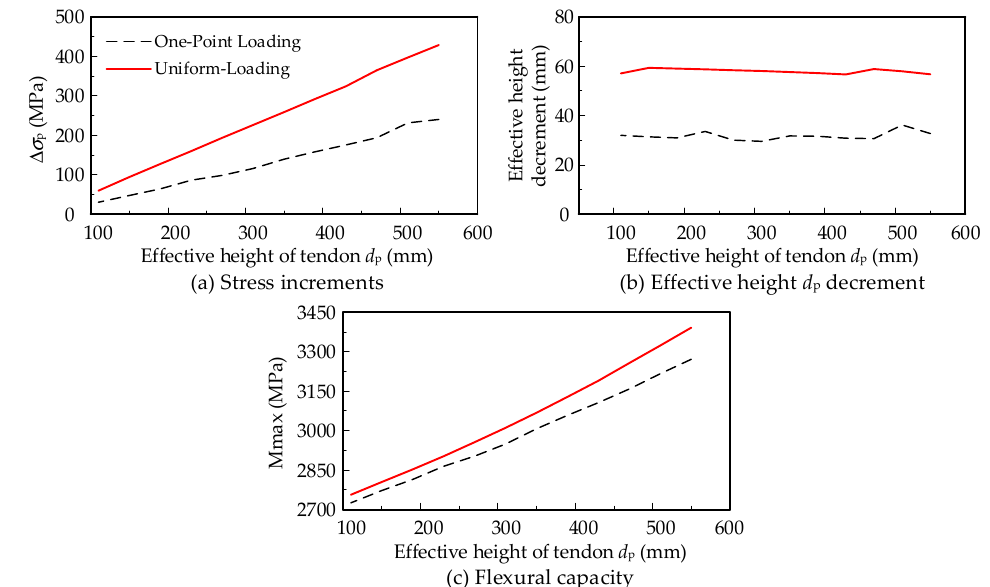
Figure 19. Effects of external tendon effective height on flexural responses of EPCB.